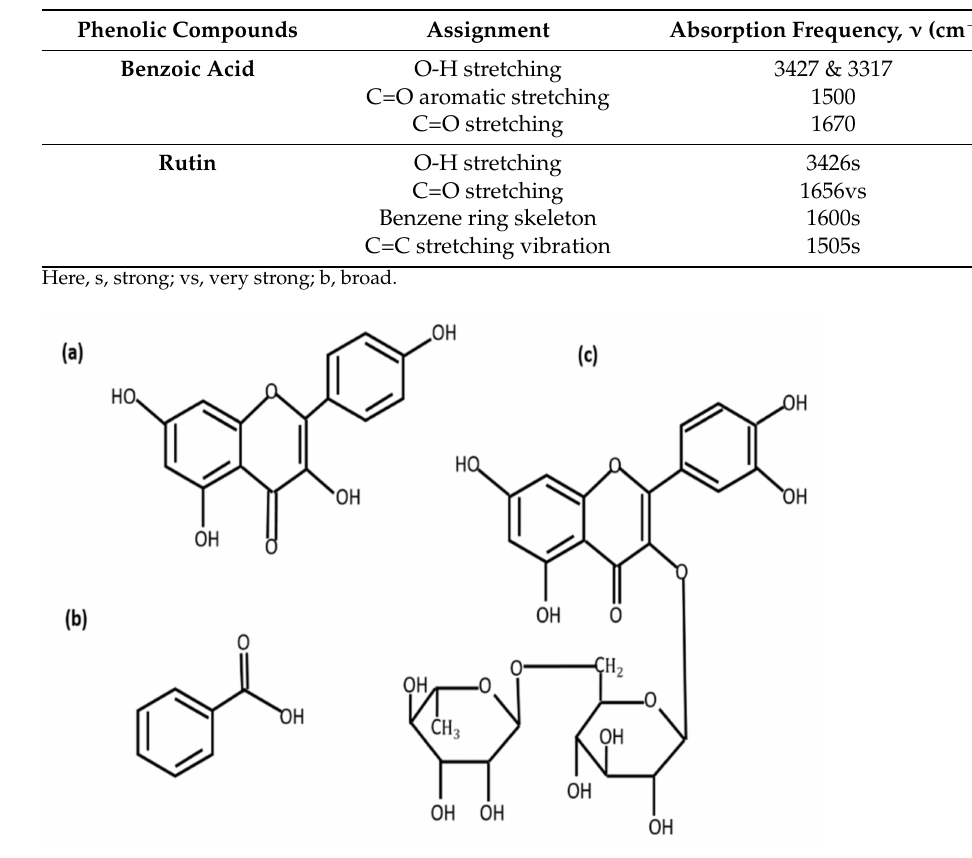
Figure 3. Chemical structures of ( a ) kaempferol, ( b ) benzoic acid, and ( c ) rutin.